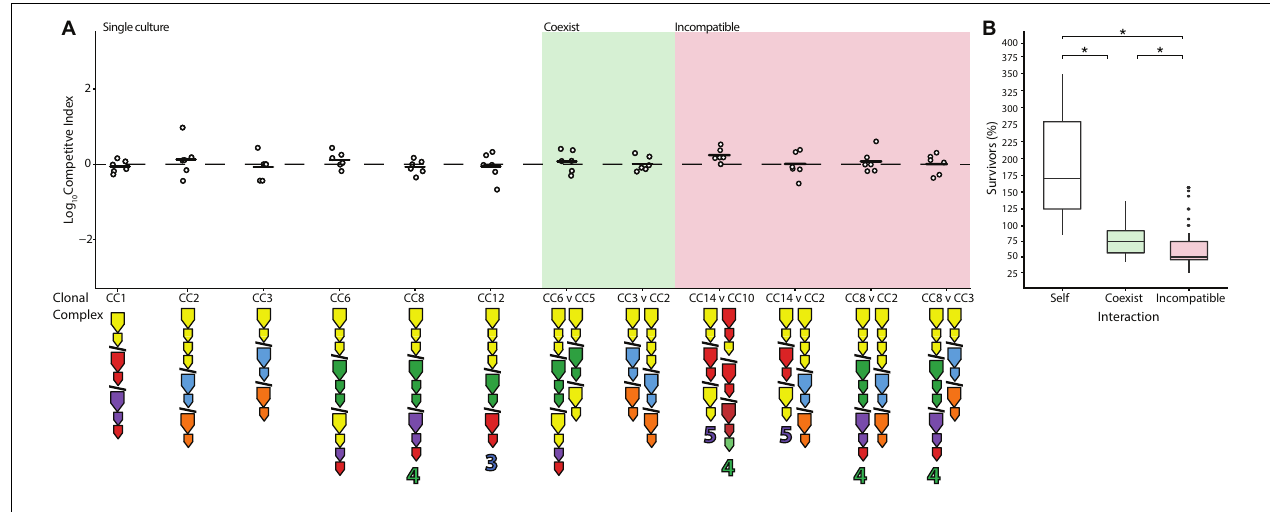
FIGURE 3 | Reduction of competition between strains with identical effector-immunity module composition. Identical (white), compatible (green), and select incompatible (red) strains were competed on agar plates at equal concentrations at 25 ◦ C for 4 h. (A) Dots indicate the log competitive index for each replicate ( N = 6), with the average shown as a bar on the y -axis. E-I module composition is indicated below strain names in accordance with Figure 1 . (B) Percentage of surviving cells compared to the original input of identical (white), compatible (green), and incompatible (red) strains with non-significant competitive outcomes (excluding instances of one strain outcompeting the other). Box-and-whiskers plots show median, 25th and 75th percentiles (upper and lower hinges), and 1.5 interquartile range (whiskers). Outliers are shown as individual dots. Asterisks (*) indicate statistically significantly different means between each group (unpaired t test p <